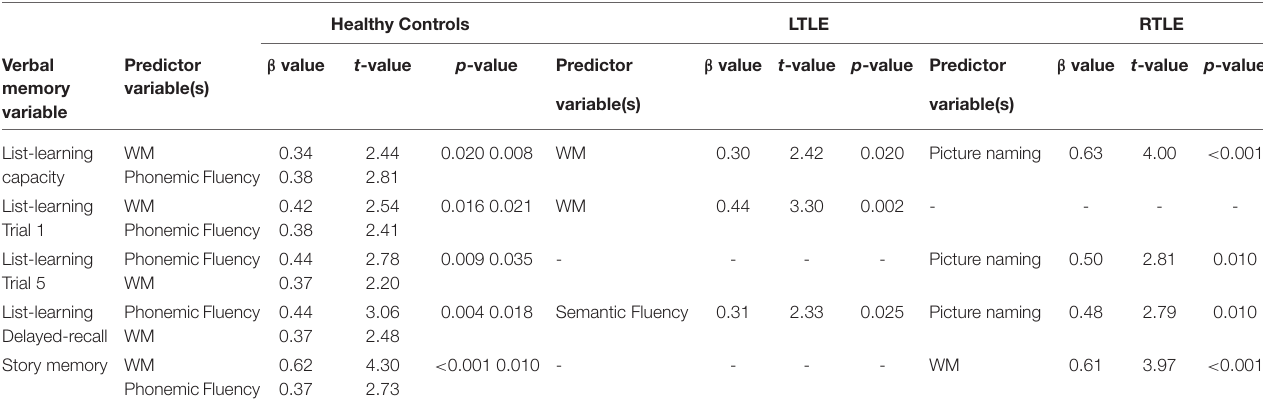
TABLE 5 | Predictor variables for verbal learning and memory measures in participant groups, after controlling for disease characteristics and/or sociodemographic relevant variables (final model interpretation). Healthy Controls LTLE